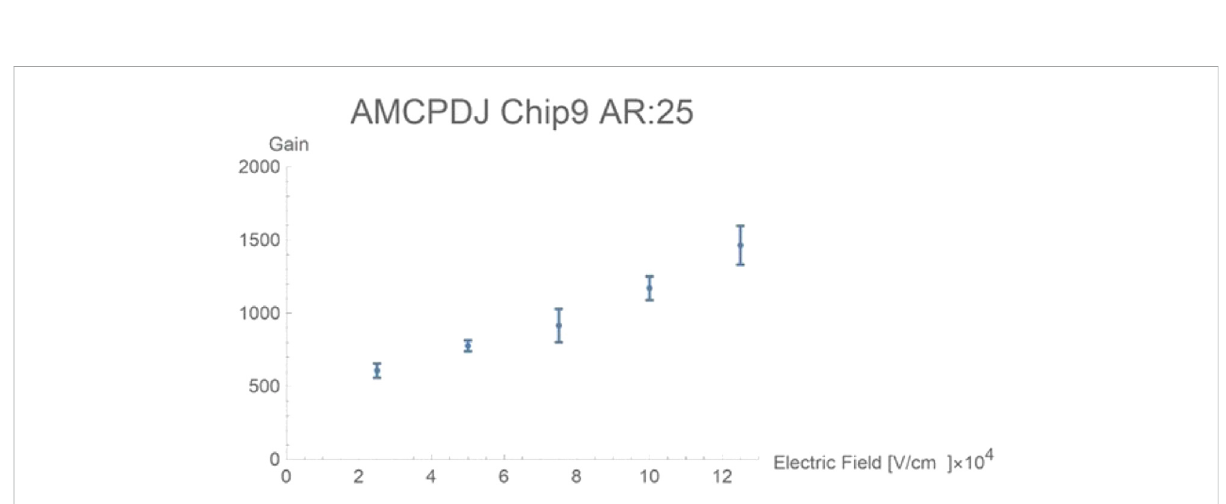
FIGURE 9 Measured gain value as a function of bias fi eld in the channel for an AMCP with aspect ratio of 25. Image taken from